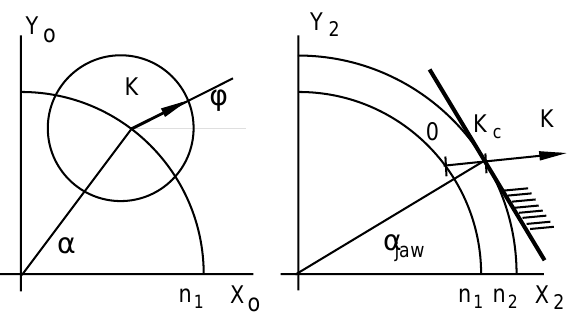
FIG. 1. The line of the scattered particles at the primary collimator parametrized with (cid:115) (cid:110) (cid:49) (cid:44) a (cid:44) (cid:75) (cid:44) f (cid:100) transforms at the location of a secondary collimator to another line which crosses the circle of radius (cid:110) (cid:50) when (cid:75) (cid:173) (cid:75) (cid:99) whatever a and f ; see Eq. (10). A flat jaw at azimuth a (cid:106)(cid:97)(cid:119) is sufficient to cut at amplitude (cid:65) (cid:173) (cid:110) (cid:50) ; see